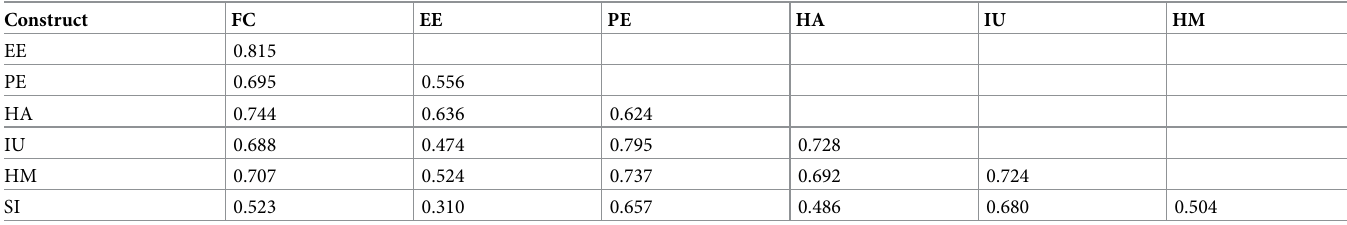
Table 6. Construct discriminant validity—Heterotrait-Monotrait Ratio. Construct